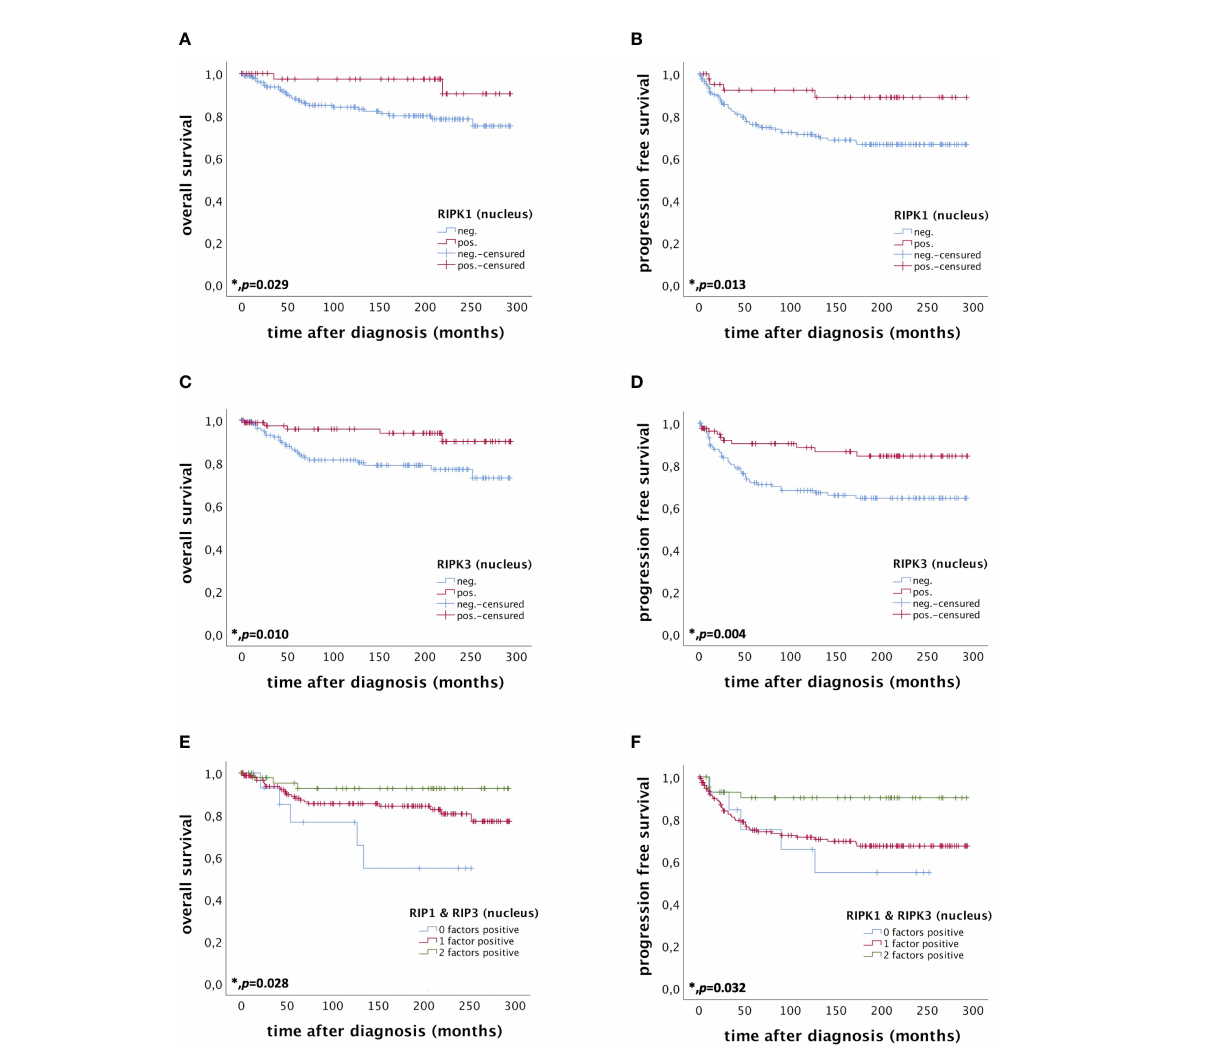
FIGURE 3 OS and PFS of patients diagnosed with cervical cancer correlated with nuclear RIPK1 expression (A, B) nuclear RIPK3 expression (C, D) and simultaneous expression of RIPK1 and RIPK3 in the nucleus (E, F) . (A) OS of patients diagnosed with cervical cancer correlated with nuclear RIPK1 expression. Nuclear RIPK1 expression (n = 47) was associated with longer OS in cervical cancer patients compared to patients not expressing RIPK1 (n = 180) (p = 0.029). (B) PFS of patients diagnosed with cervical cancer correlated with nuclear RIPK1 expression. Nuclear RIPK1 expression (n = 43) was associated with longer PFS in cervical cancer patients compared to patients not expressing RIPK1 (n = 172) (p = 0.013). (C) OS of patients diagnosed with cervical cancer correlated with nuclear RIPK3 expression. High nuclear RIPK3 expression (n = 86) was associated with longer OS in cervical cancer patients compared to patients with low RIPK3 expression (n = 141) (p = 0.010). (D) PFS of patients diagnosed with cervical cancer correlated with nuclear RIPK3 expression. High nuclear RIPK3 expression (n = 81) was associated with longer PFS in cervical cancer patients compared to patients with low RIPK3 expression (n = 134) (p = 0.004). (E) OS of patients diagnosed with cervical cancer correlated with simultaneous expression of nuclear RIPK1 and RIPK3. Expression of both RIPK1 and RIPK3 (n = 48) in the nucleus was associated with longer OS in cervical cancer patients (p = 0.028) compared to patients expressing only one (n = 162) or no factor (n = 15). (F) PFS of patients diagnosed with cervical cancer correlated with simultaneous expression of nuclear RIPK1 and RIPK3. Expression of both RIPK1 and RIPK3 (n = 44) in the nucleus was associated with longer OS in cervical cancer patients (p = 0.032) compared to patients expressing only one (n = 155) or no factor (n =